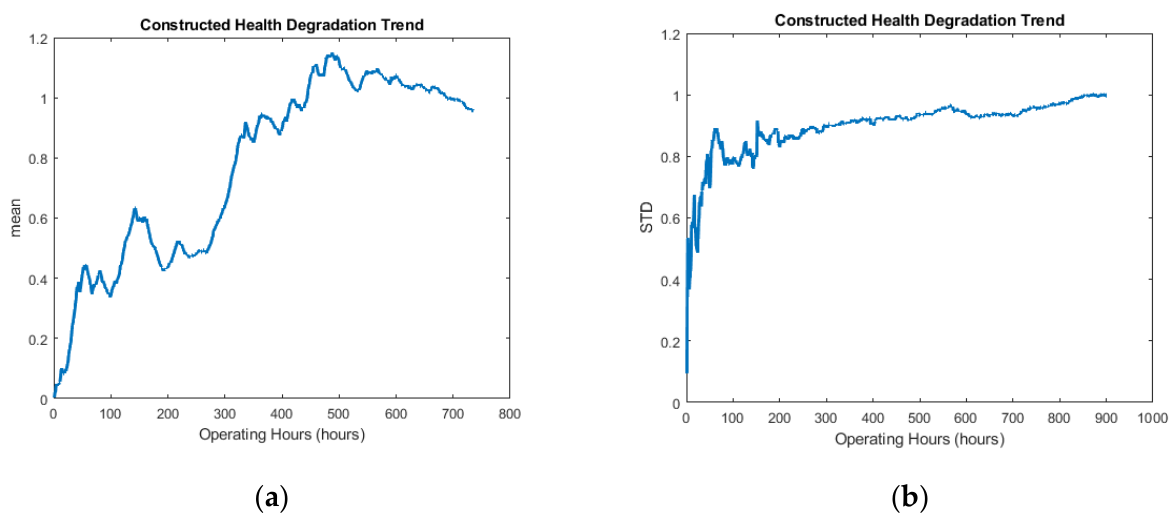
Figure 4. Constructed health degradation trends for ( a ) channel 2 and ( b ) channel 4.